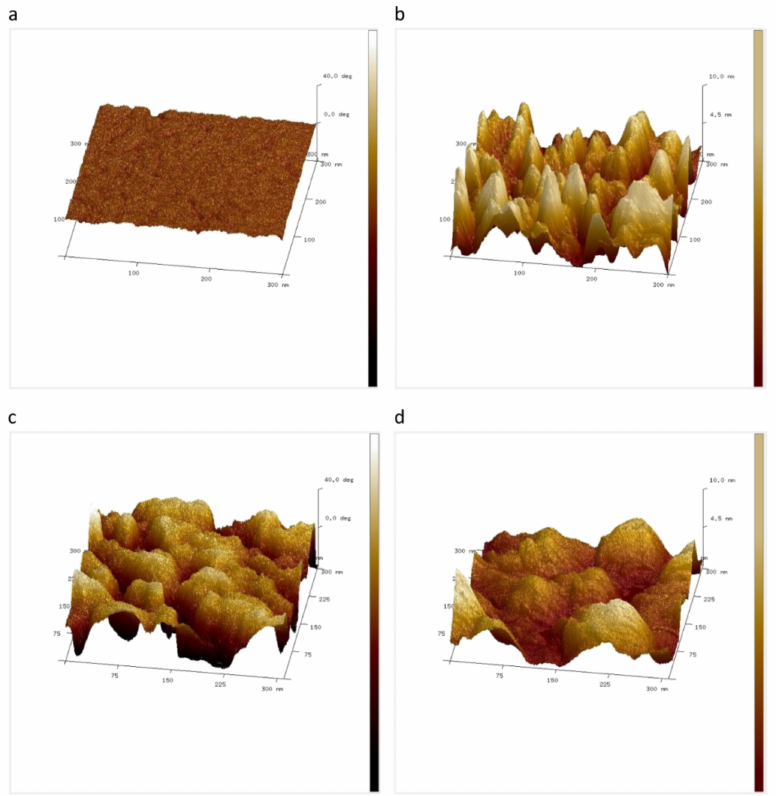
Figure 11. AFM images of alginate films. ( a ) phase image and ( b ) topography image of pure alginate film; ( c ) phase image and ( d ) topography image of alginate films with chlorhexidine hexametaphos- phate particles. Lateral image dimensions are 300nm; the z -axis represents 40 ◦ (phase images) and 10 nm (topography), respectively. Reprinted from [169], originally published under a CC-BY